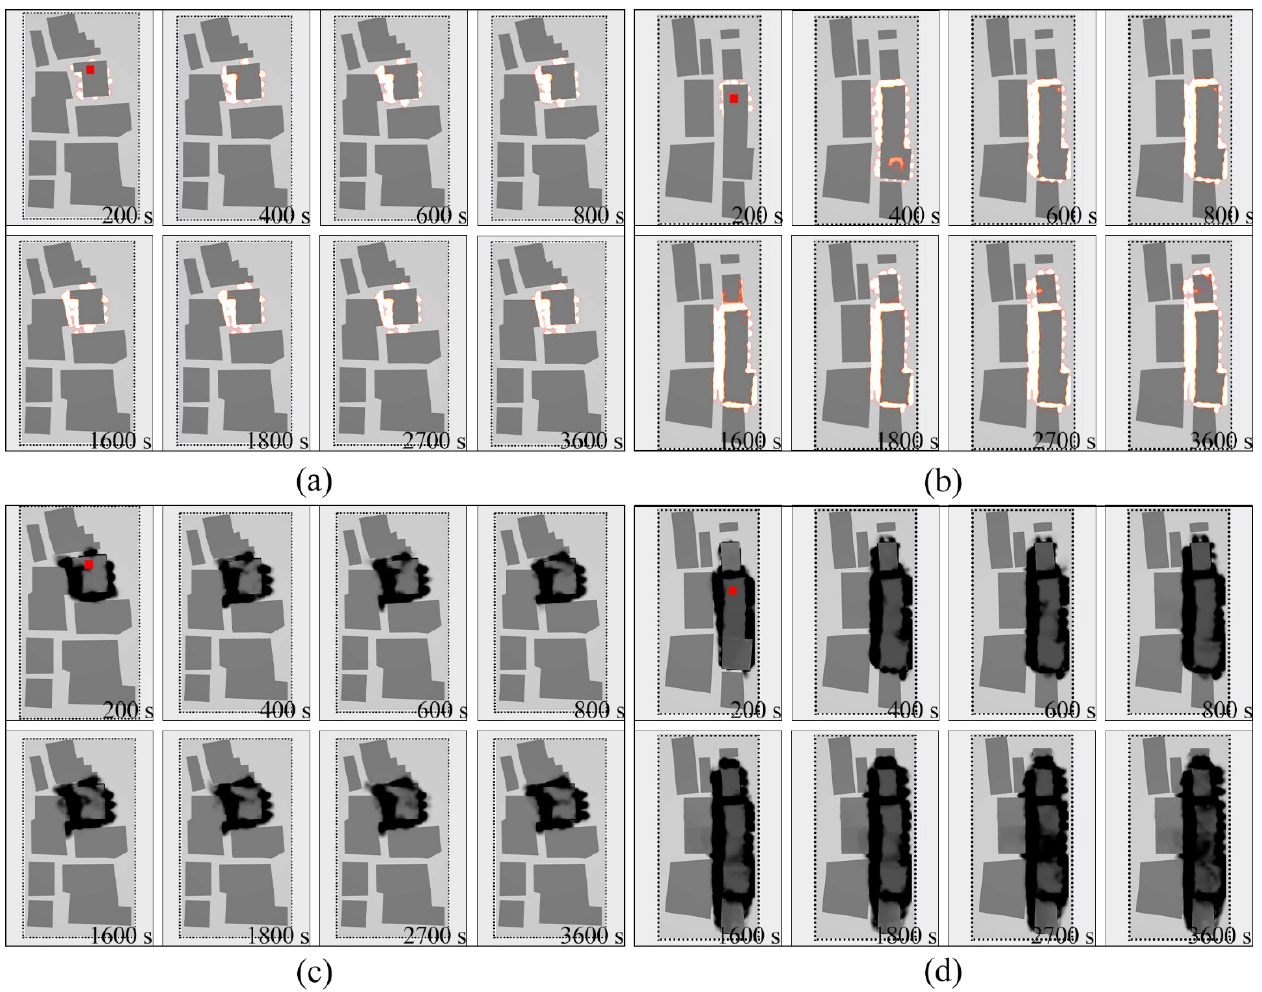
Figure 19. ( a ) Fire combustion status of houses at different times in the crooked street; ( b ) fire com- bustion status of houses at different times in the straight street; ( c ) smoke status of areas at different times in the crooked street; and ( d ) smoke status of areas at different times in the straight street. The results for the number of burning dwellings for different street patterns are shown in Figure 20. From 200 s to 1800 s, the growth rate of the number of burning dwellings in the straight street was significantly faster than that in the crooked street. The number of dwellings burning in the stable burning phase was also much higher in the straight street than in the curved street. The wind was blocked by the crooked streets and the windspeed was reduced. The houses in the crooked streets were in a stable wind environment, which slowed down the spread of fire to the nearby houses. However, the wind- speed of the straight streets was not impeded and the high windspeed intensified the spread of fire and smoke in all directions. The zigzagging street layout of High chair Vil- lage is conducive to reducing the risk of serious fires.